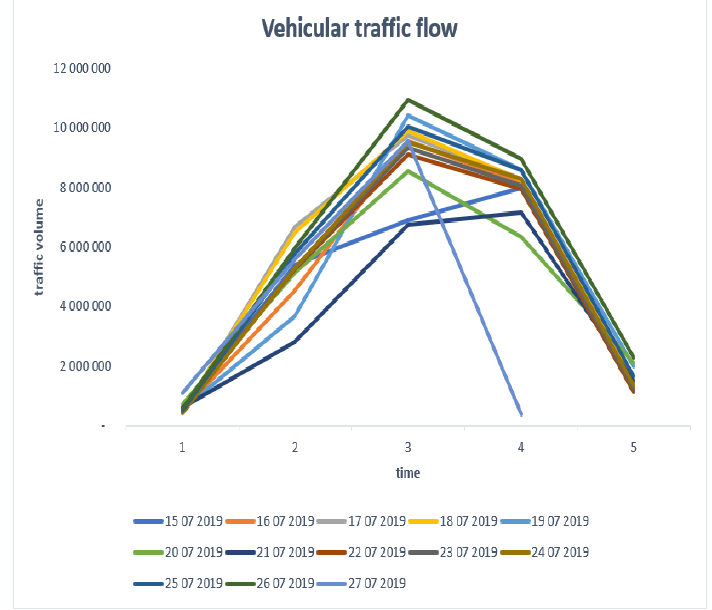
Figure 11. Road intersection 3.